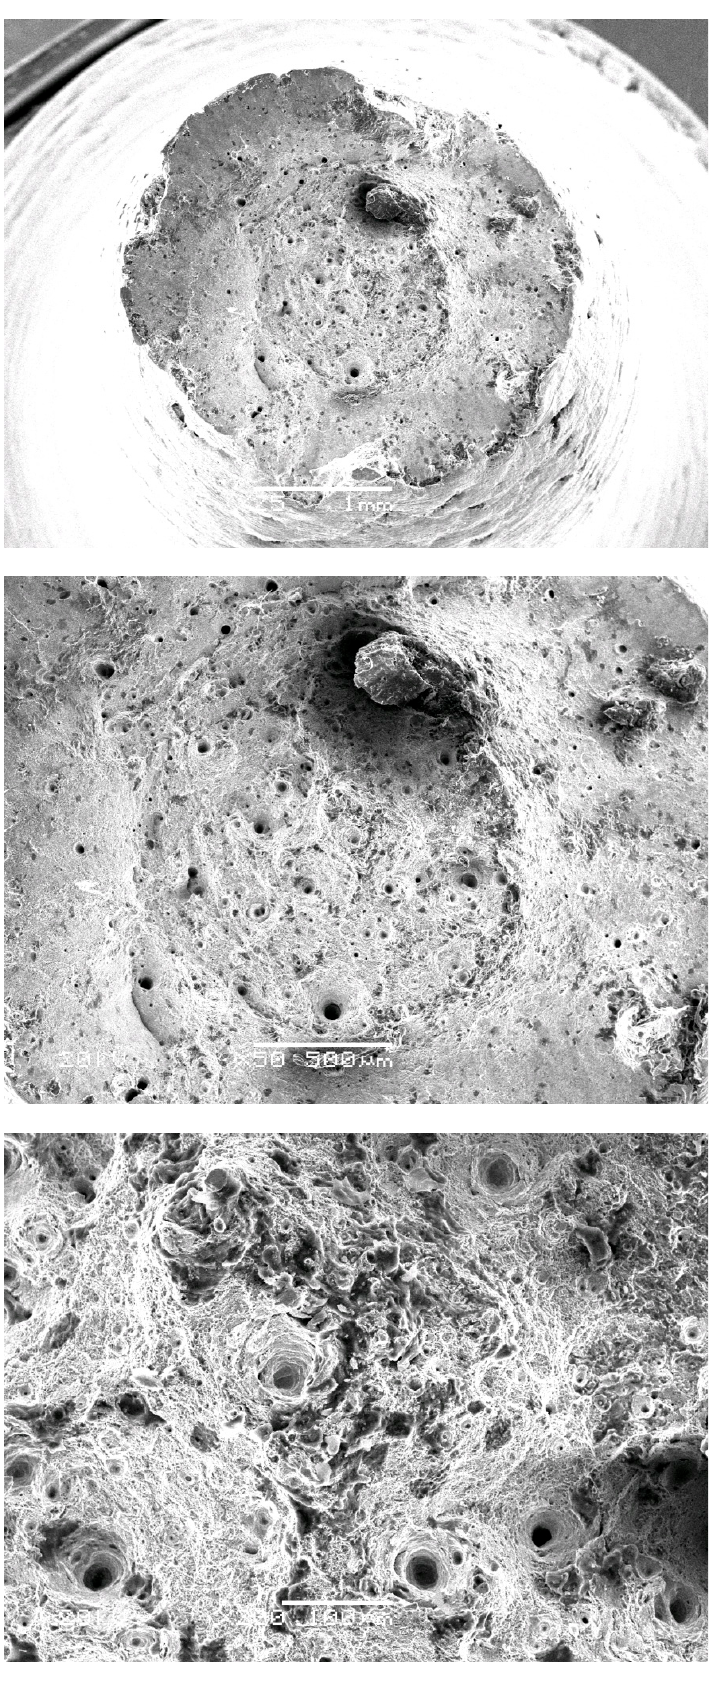
Figure 5. SEM micrographs (25×, 50× and 200×) of specimen 1.